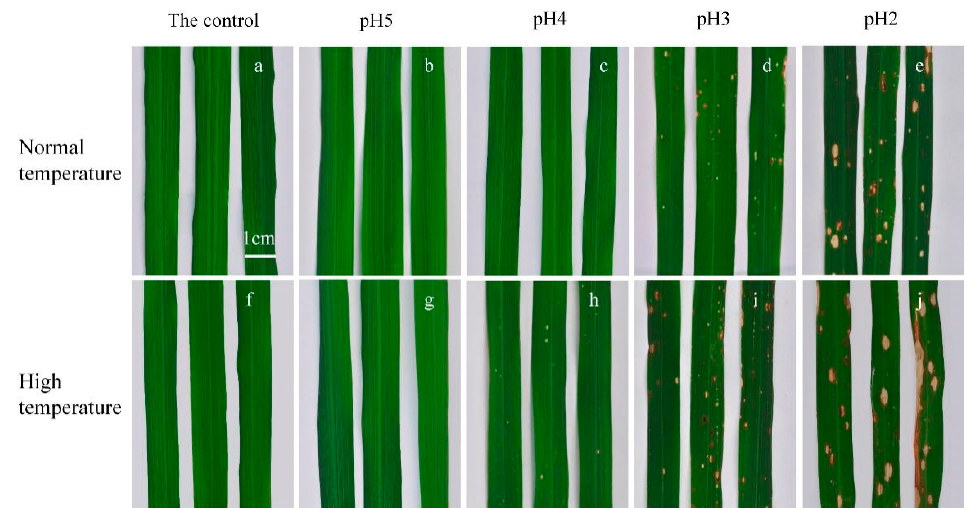
Figure 5. Leaves of rice seedlings exposed to different pH acid rain for 7 days under normal ‐ and high ‐ temperature conditions. ( a ‐ e ) The leaves subjected to normal temperature treatment. ( f ‐ j ) The leaves subjected to high temperature treatment. ( a , f ) The leaves with the control (pH 7) treatment. ( b , g ) The leaves with pH 5 acid rain treatment. ( c , h ) The leaves with pH 4 acid rain treatment. ( d , i ) The leaves with pH 3 acid rain treatment. ( e , j ) The leaves with pH 2 acid rain treatment.